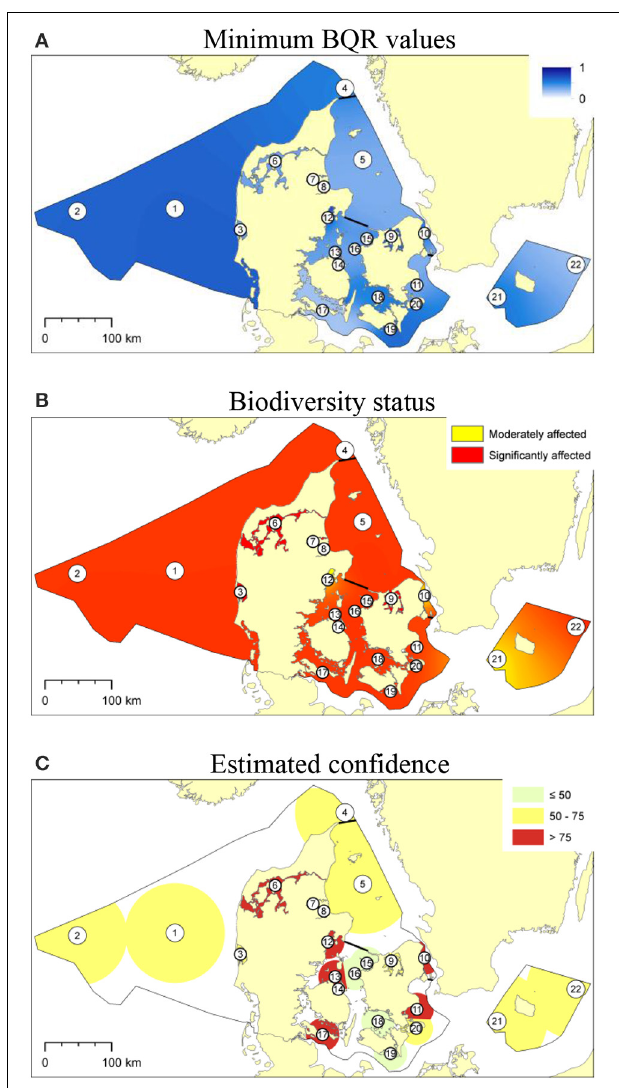
FIGURE 3 | Spatial distribution of BQR’s (A), biodiversity status (B), and the estimated confidence (C). For illustration purposes representative points were chosen to represent the assessment sectors. From these points the results were spread to the marine area using a spline with barriers technique. For the six closed fjords (sectors 3, 6–9, 14) the values were spread evenly over the whole